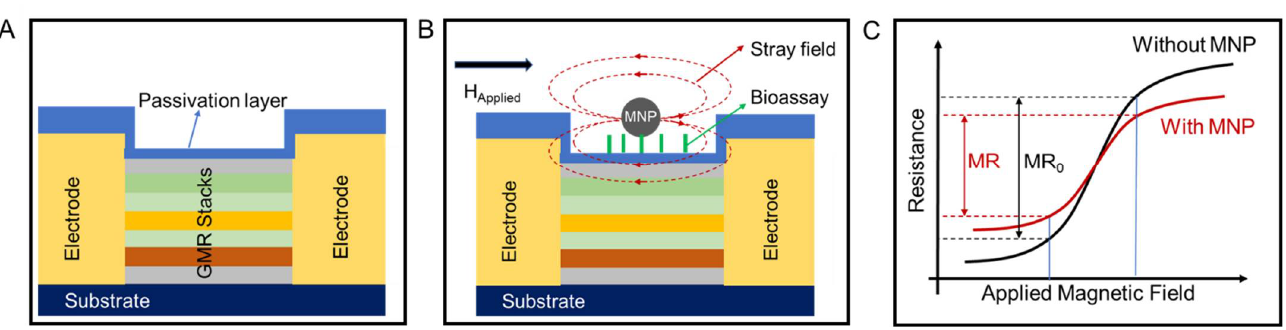
Figure 1. Schematics of ( A ) a typical GMR biosensor, ( B ) a functionalized GMR biosensor under an applied field, and ( C ) R-H curves of a GMR biosensor with and without conjugated MNPs on the surface.